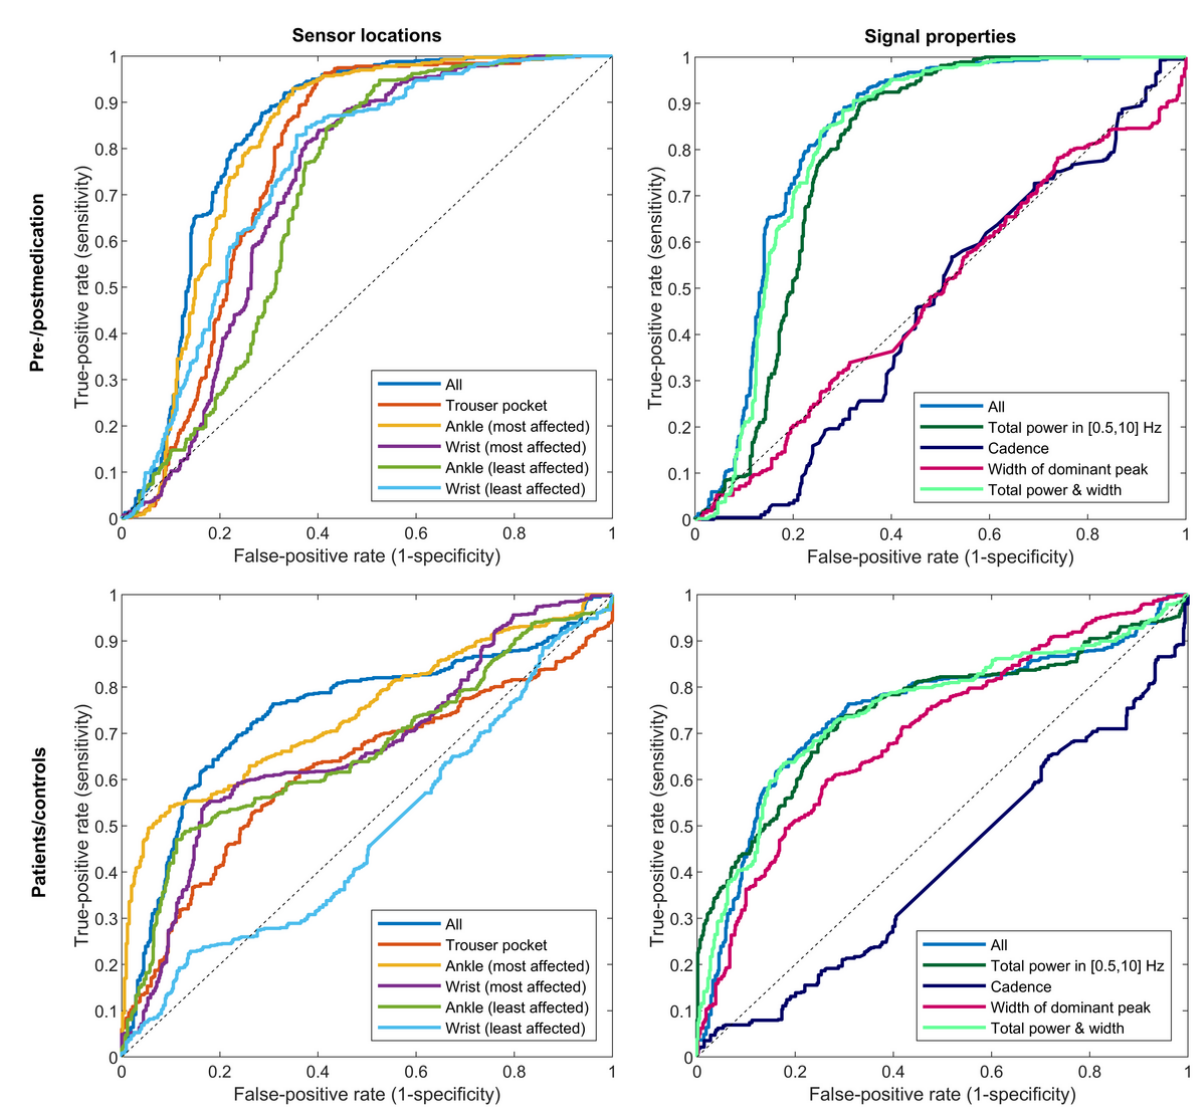
Figure 4. Receiver operating characteristic curves of the logistic classifiers, averaged over the cross-validation folds. Top half: premedication and postmedication classification. Bottom half: patients and controls classification. Left half: comparison between different sensor locations. Right half: comparison between different signal properties, based on all sensor locations